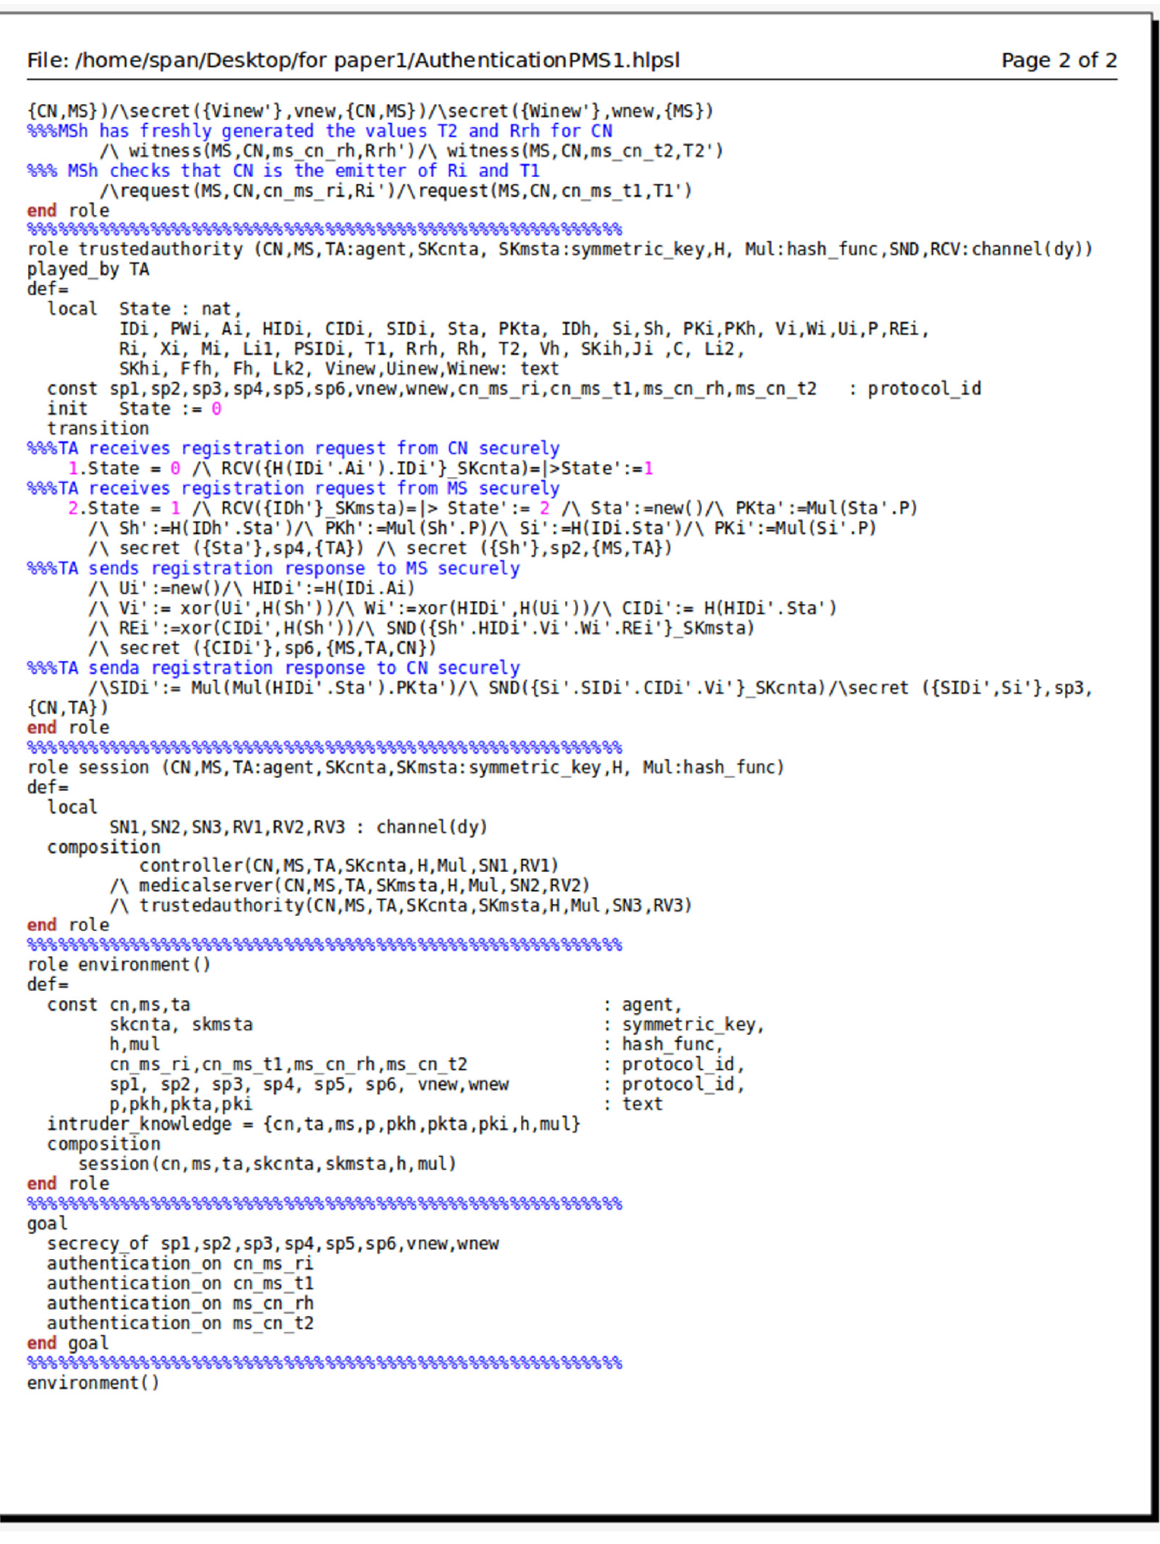
Figure 7. The HLPSL code of P-I.